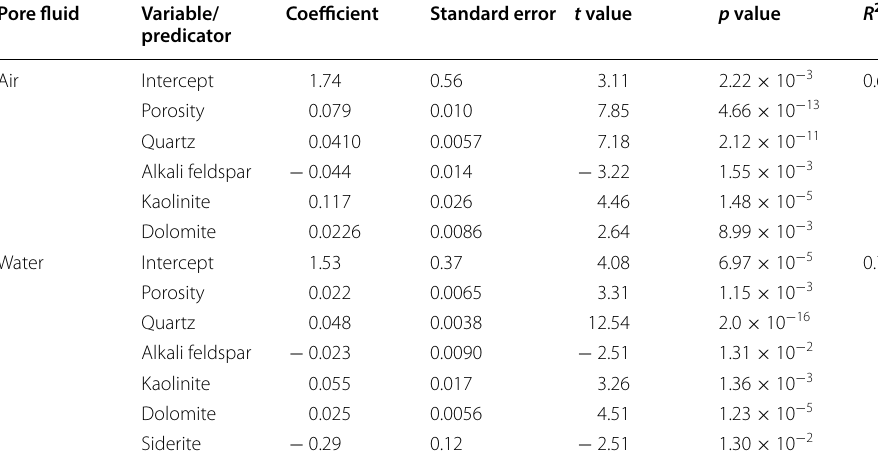
Table 4 Regression coefficients of multiple regression models of the variable λ and water-saturated sandstones Pore